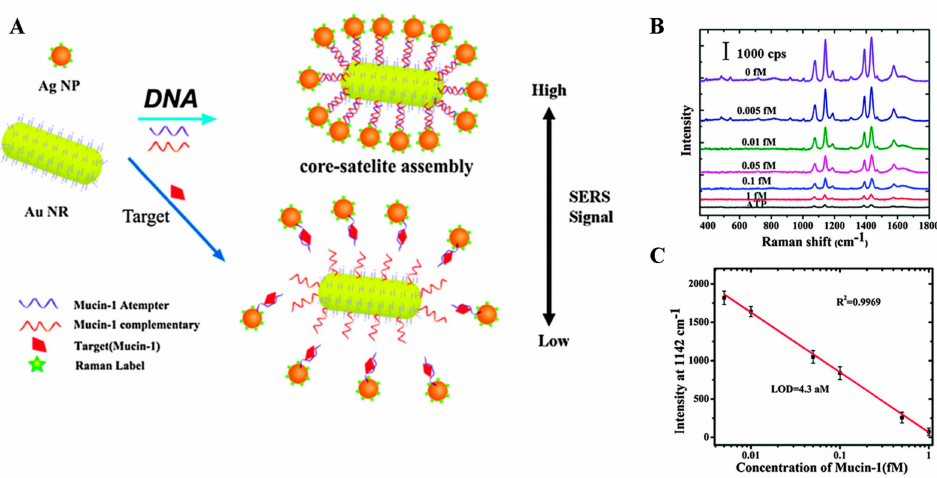
Figure 8. ( A ) Mucin-1 detection based on SERS with bimetallic core (gold nanorods)—satellite (silver nanoparticles) assemblies [77]. ( B ) SERS spectra of Mucin-1 detection; ( C ) Standard curve for Mucin-1 detection with corresponding peak intensities at 1142 cm − 1